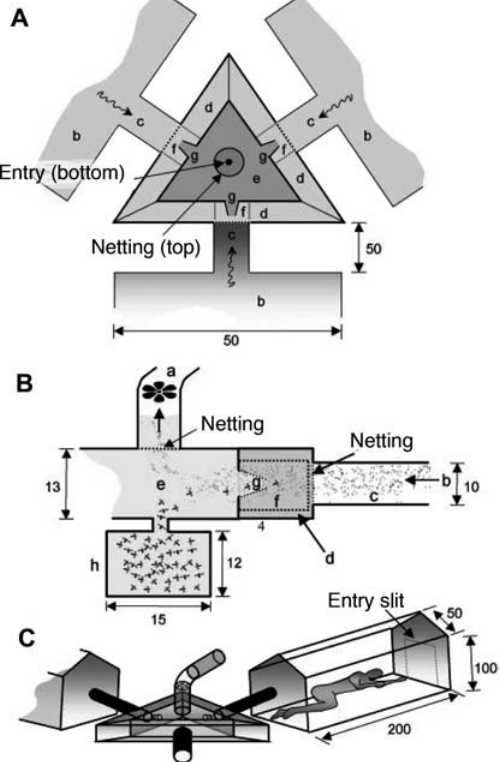
Figure 1. Experimental Set-Up (A)–(C) Top (A), cross-sectional (B), and three-dimensional (C) views of the olfactometer used. The fan (a) draws air ( ; 130 l/min per tent) from the three tents (b) to the outside environment via PVC pipes (c), trap chambers (d), and a central chamber (e). Each trap chamber contains a collecting cage (f) into which an exit trap opens (g). The fan pipe and release cup (h) are fitted to the top and bottom of the central chamber, respectively. Diagrams are not shown to scale; all dimensions are in centimetres. Source: